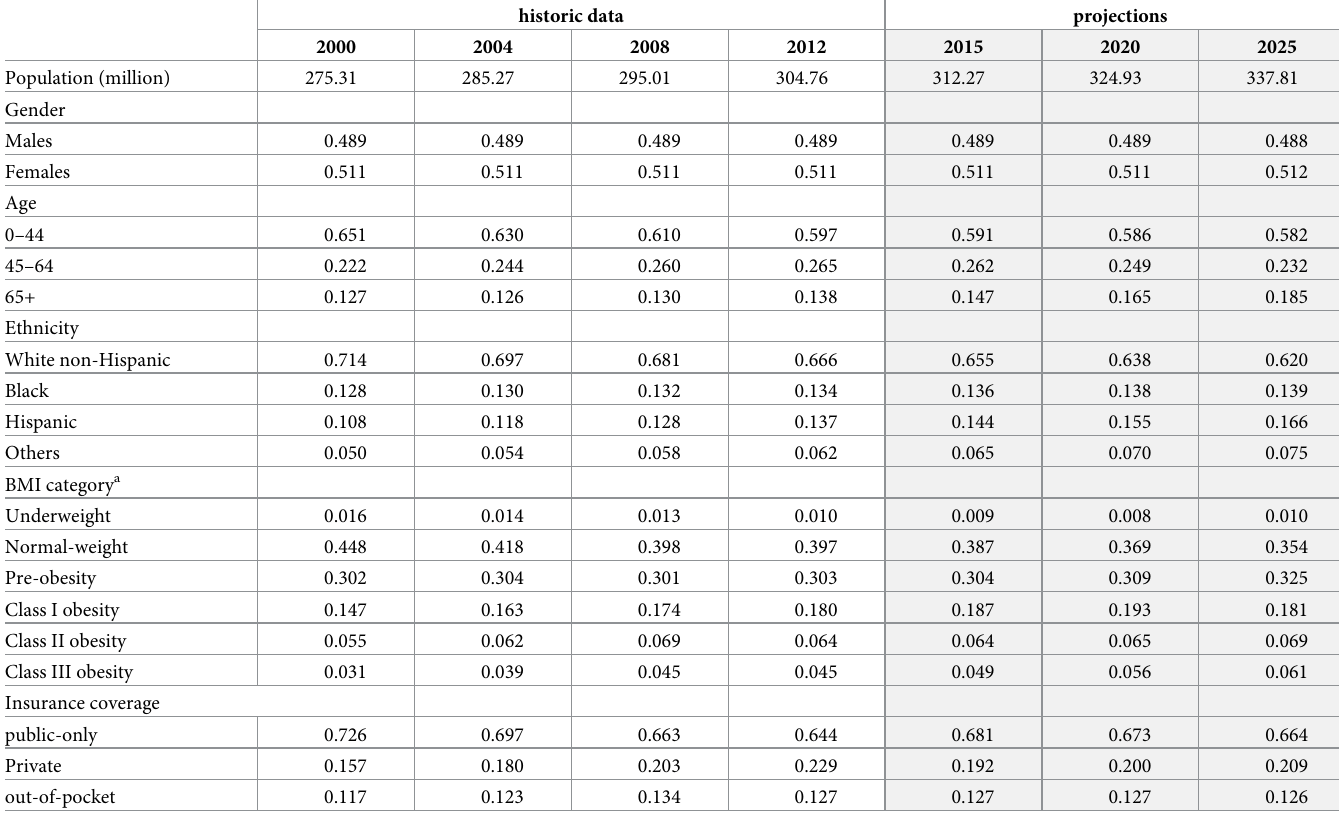
Table 1. Key socio-demographic characteristics; prevalence rate in the US population, 2000–2025.